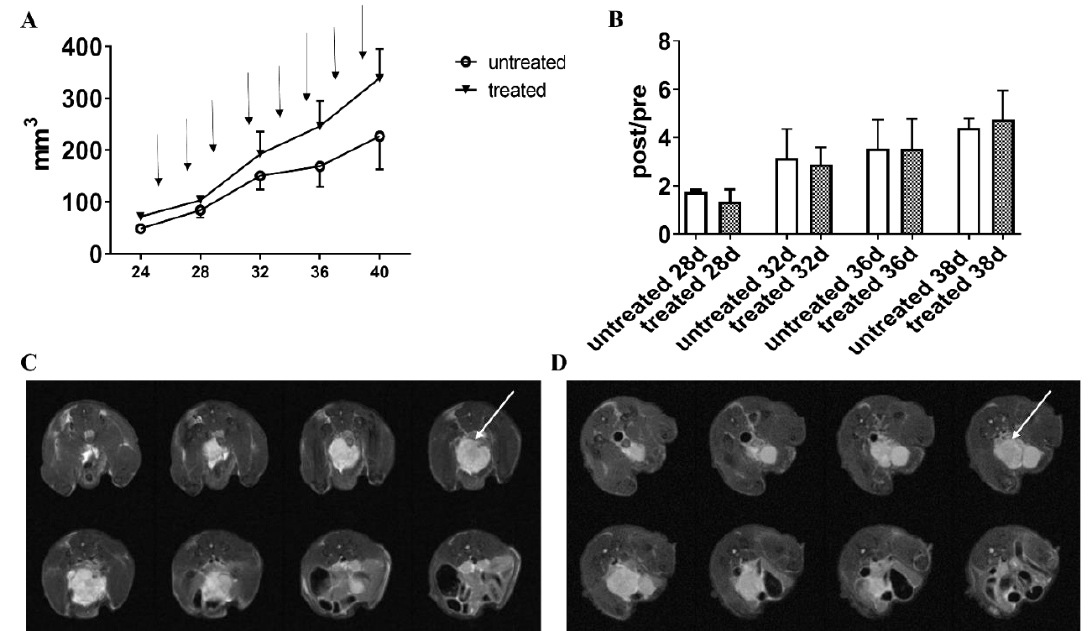
Figure 8. PC3 tumor volumes for the PC3 orthotopic model measured from MRI T 2 -weighted anatomical images. The black arrows indicate the day of Esomeprazole administration (dose: 2.5 mg/kg b.w. by gavage, every other day) ( A ). Normalized tumor volumes (calculated by dividing the post-treatment volume measurements by the volume measured on the day of mice randomization into the two groups, ( B )). Representative T 2 -weighted anatomical images of orthotopic PC3 prostate tumors (8 slices) of untreated ( C ) and treated mice ( D ) at one week post-Esomeprazole treatment. The white arrows point the tumor mass.